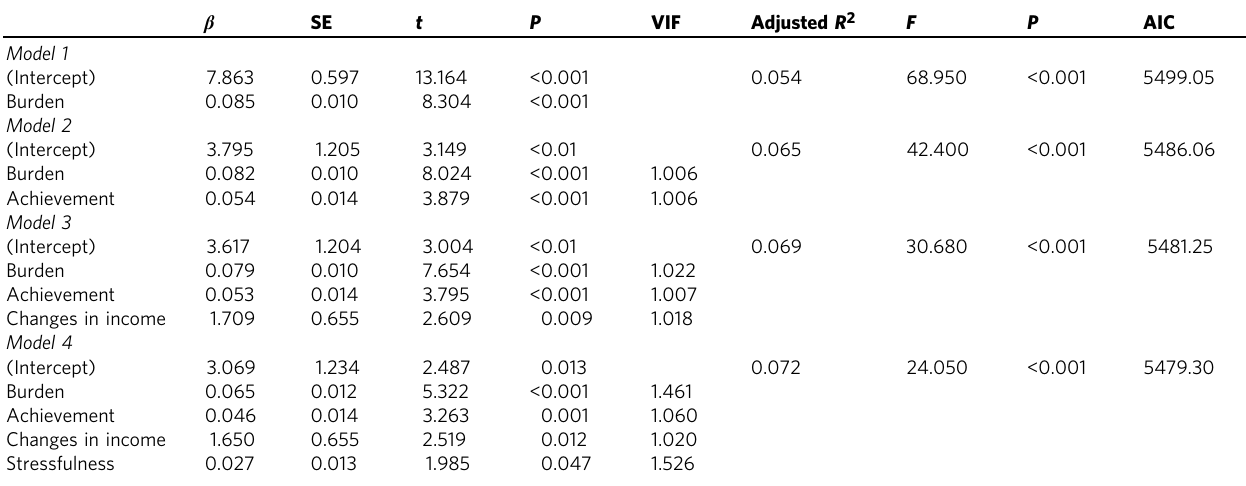
Table 2 Prediction model of the level of the disruption of core beliefs.